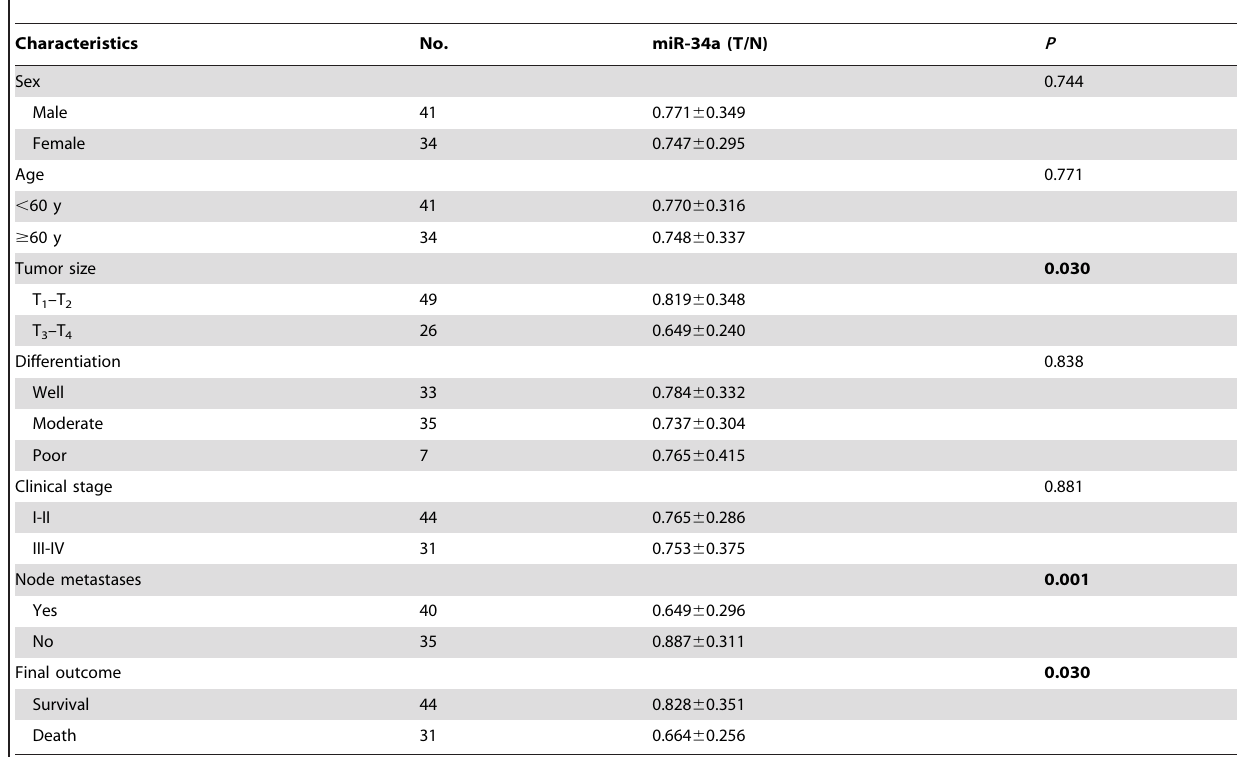
Table 1. Correlation between miR-34a expression and clinicopathologic parameters in 75 TSCC patients.